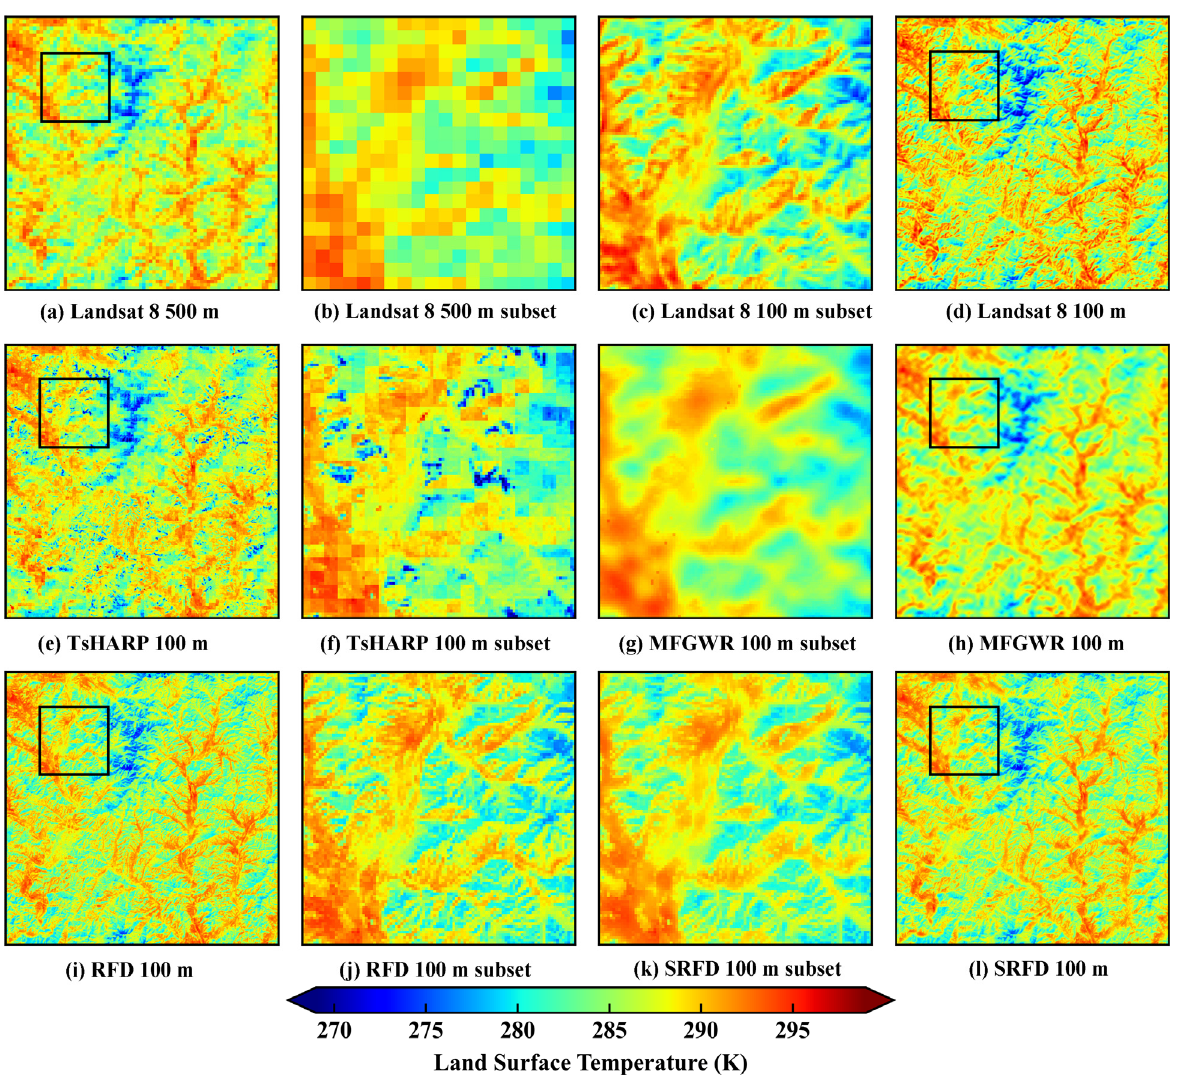
Figure 8. Visual comparison of different downscaling methods in image C1. ( a ) Landsat 8 LST (500-m). ( b ) Subset of Landsat 8 LST (500-m). ( c ) Subset of Landsat 8 LST (100-m). ( d ) Landsat 8 LST (100-m). ( e ) TsHARP downscaled LST (100-m). ( f ) Subset of TsHARP downscaled LST (100-m). ( g ) Subset of MFGWR downscaled LST (100-m). ( h ) MFGWR downscaled LST (100-m). ( i ) RFD downscaled LST (100-m). ( j ) Subset of RFD downscaled LST (100-m). ( k ) Subset of SRFD downscaled LST (100-m). ( l ) Subset of SRFD downscaled LST (100-m). Table 3. Quantitative indicators for all downscaled LST images with different